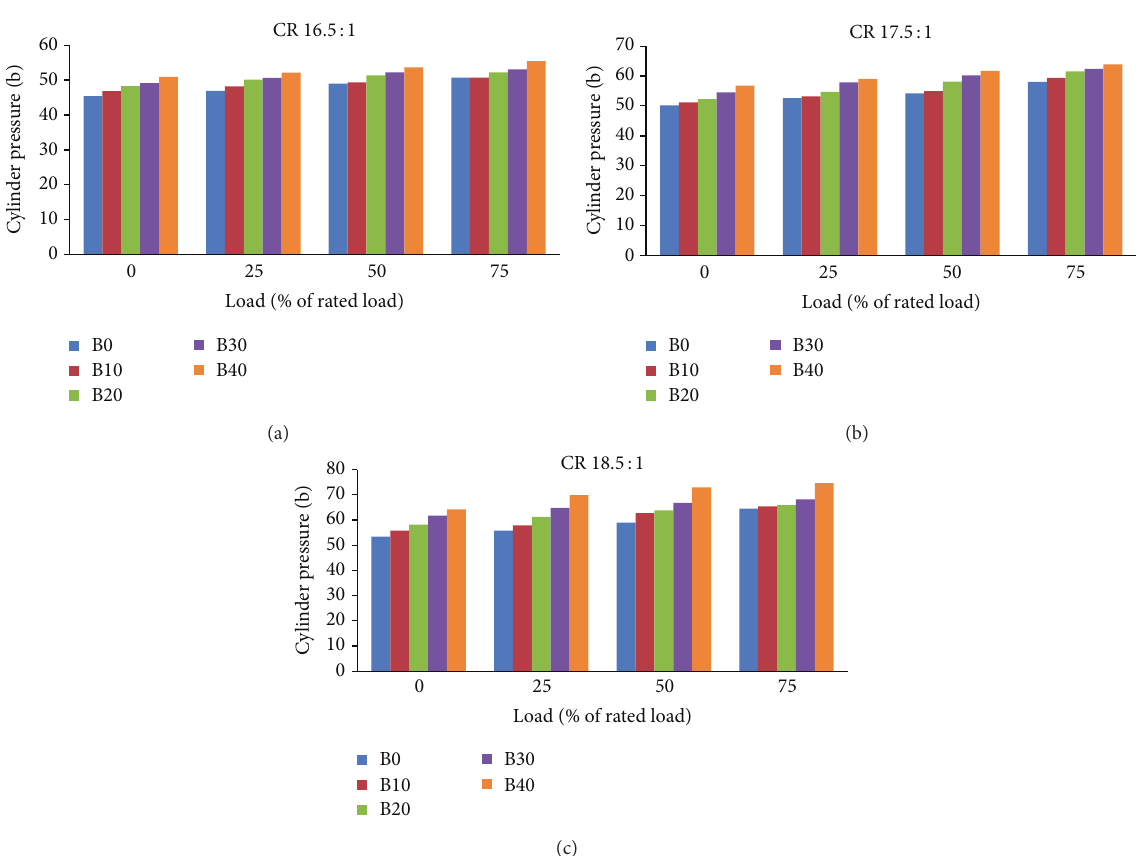
ester blends is slightly higher than the engine running with diesel at 75% of rated load and compression ratios. There